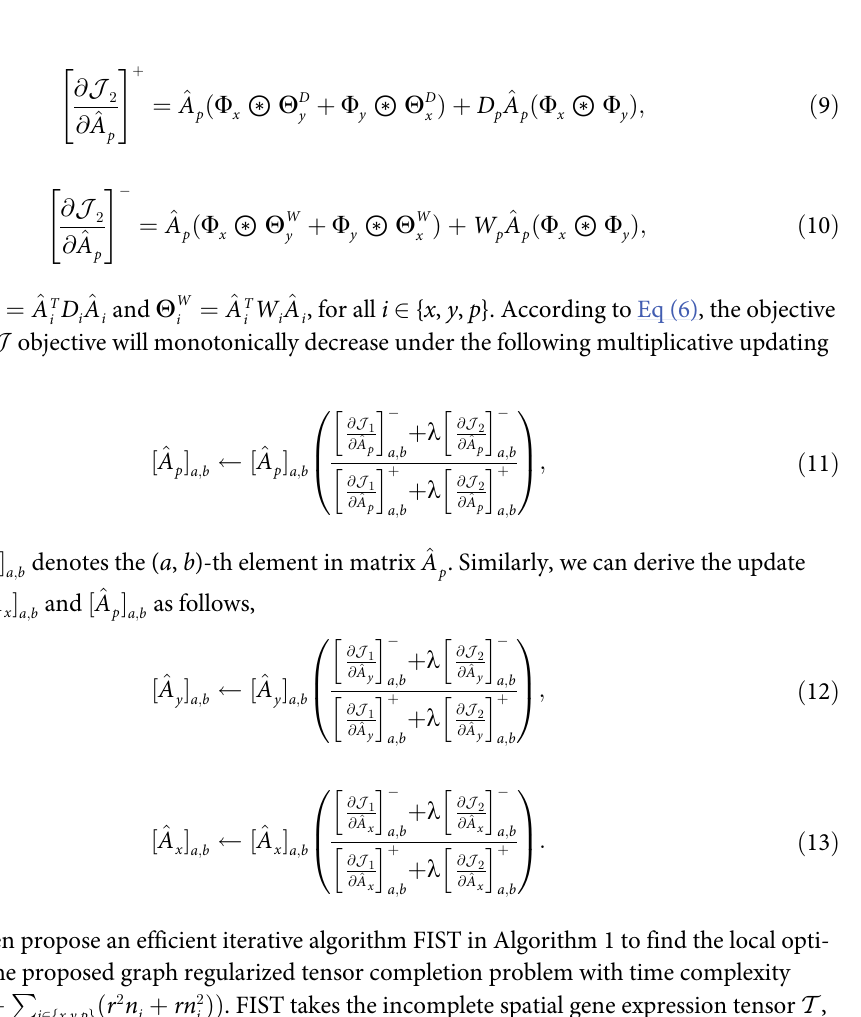
Algorithm 1 FIST: F ast I mputation of S patially-resolved transcriptomes by graph-regular- ized T ensor